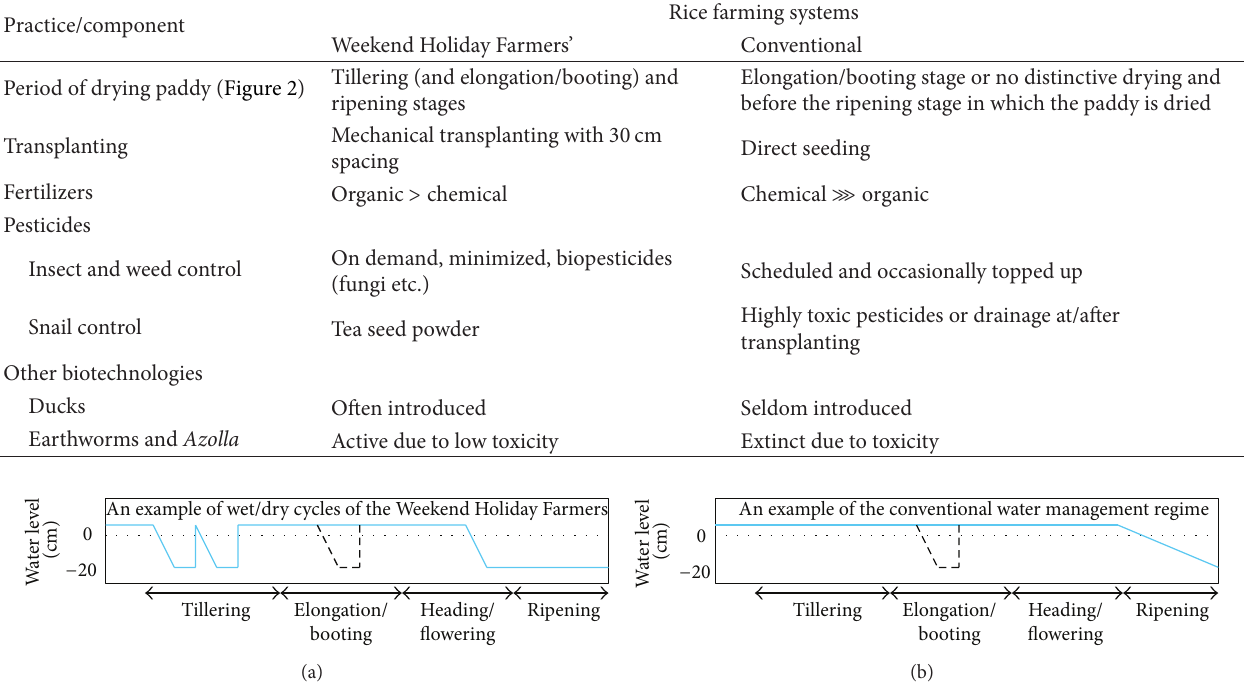
Figure 2: Schematic diagrams of water regimes of the Weekend Holiday Farmers’ Network (a) and an example of conventional water management regime widely employed in Thailand (b) for rice production. The broken lines for the elongation/booting stage indicate optional dry periods which may occasionally be